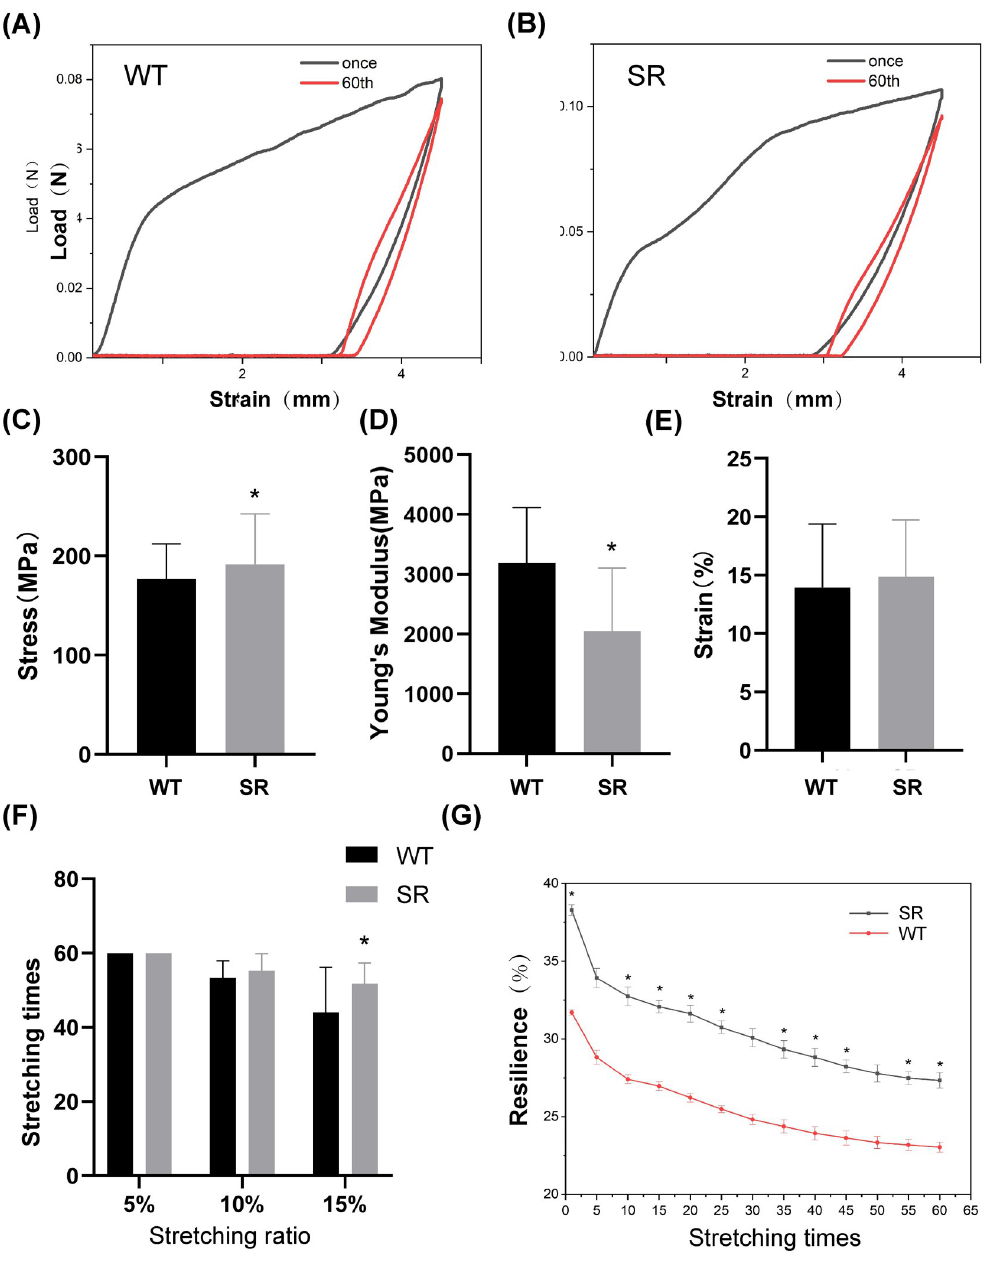
Fig 5. Mechanical properties of the recombined resilin silk fibers from the SR strains. (A, B) Stress–strain curves of WT and SR silk. (C-E) Graphs of the maximum stress, toughness and Young’s modulus, respectively. (F) Stretching times of SR and WT at different stretching ratios. (G) 15% cyclic tensile test for SR and WT. The mean ± SD derived from three independent replicate experiments. � represent p < 0.05, (Two-tailed unpaired